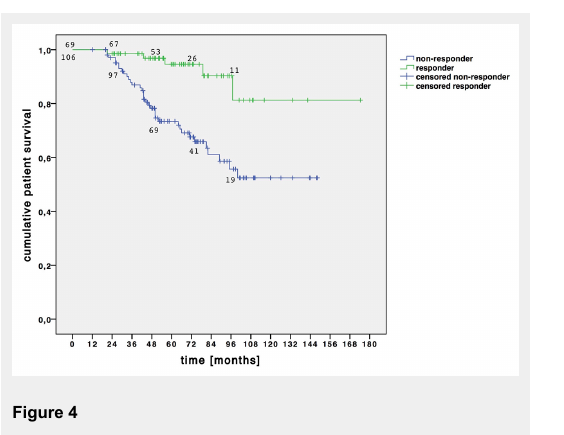
Kaplan-Meier curve of patient survival (NB: for inclusion into the study, patients had to survive for at least 2 years).